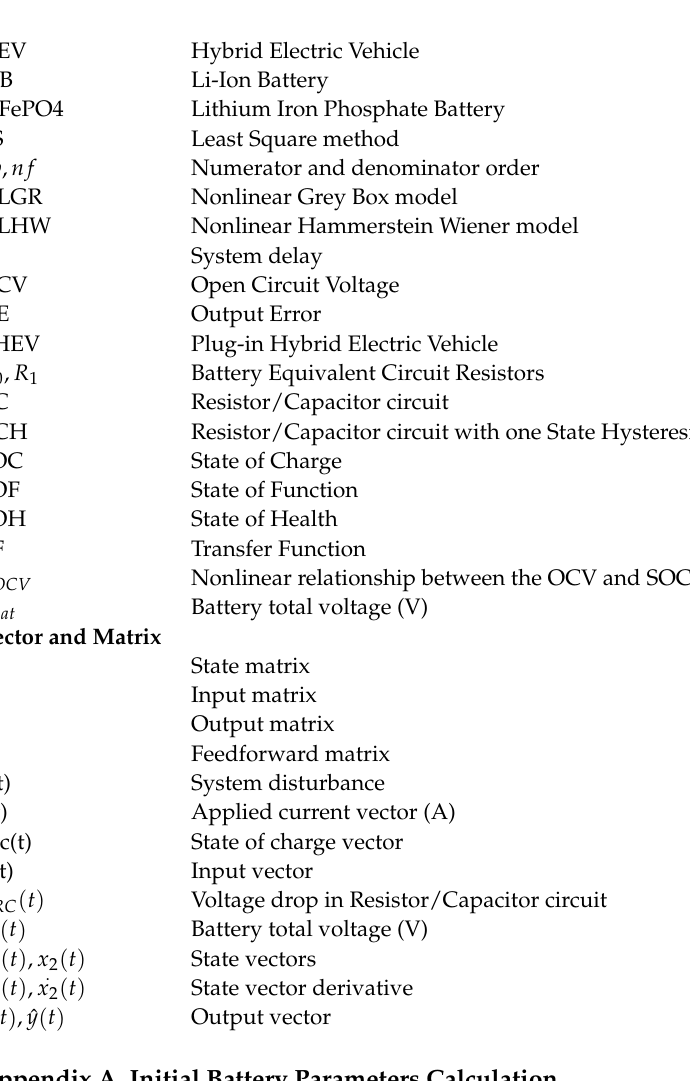
0 , R 1 and C 1 at 80% of